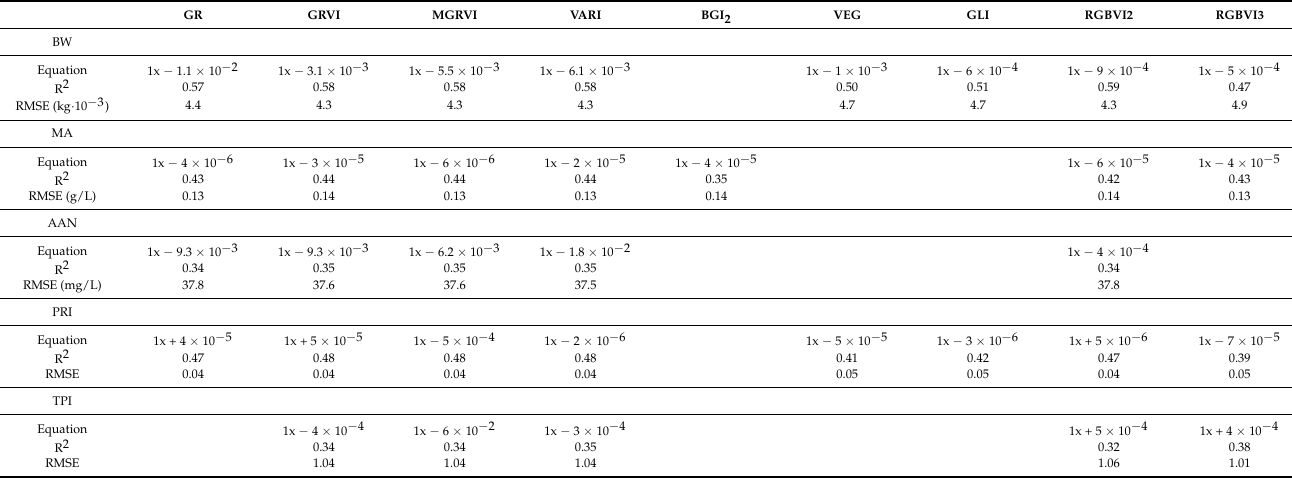
R 2 : coefficient of determination; RMSE: root mean square error. Vegetation indices. GR: simple red-green ratio; GRVI: green-red vegetation index; RGBVI: RGB-based vegetation index; MGRVI: modified green-red vegetation index; VARI: visible atmospherically resistant index; BGI 2 : simple blue-green ratio; VEG: vegetativen; GLI: green leaf index; ExG: excess green index; NGBDI: normalized green-blue difference index; RGBVI2: RGB-based vegetation index 2; RGBVI3: RGB-based vegetation index 3. Must quality variables. BW: 100-berry weight (kg 10 − 3 ); MA: malic acid (g/L); AAN: alpha amino nitrogen (mg/L); PRI: phenolic ripeness index; and TPI: total phenolic index. Figure 5 depicts scatter plots of predicted versus reference values for the best correla- tions (significance p > 0.05) between quality variables and vegetation indices: BW with the RGBVI2 (R 2 = 0.59), MA with the VARI (R 2 = 0.44), ANN with the VARI (R 2 = 0.35), PRI with the VARI (R 2 = 0.48), and TPI with the RGBVI3 (R 2 =